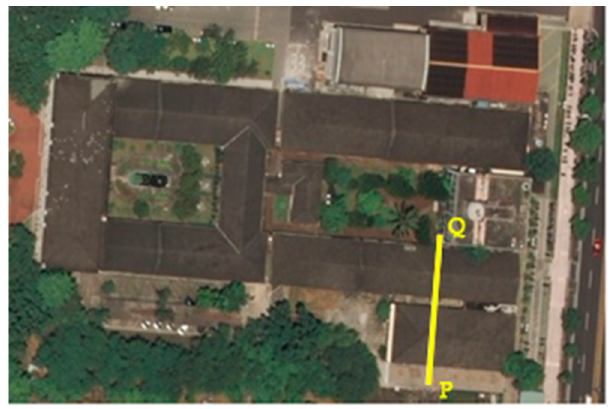
Figure 1. C s values simulated for the different slopes of a roof and derived from the tensor voting method